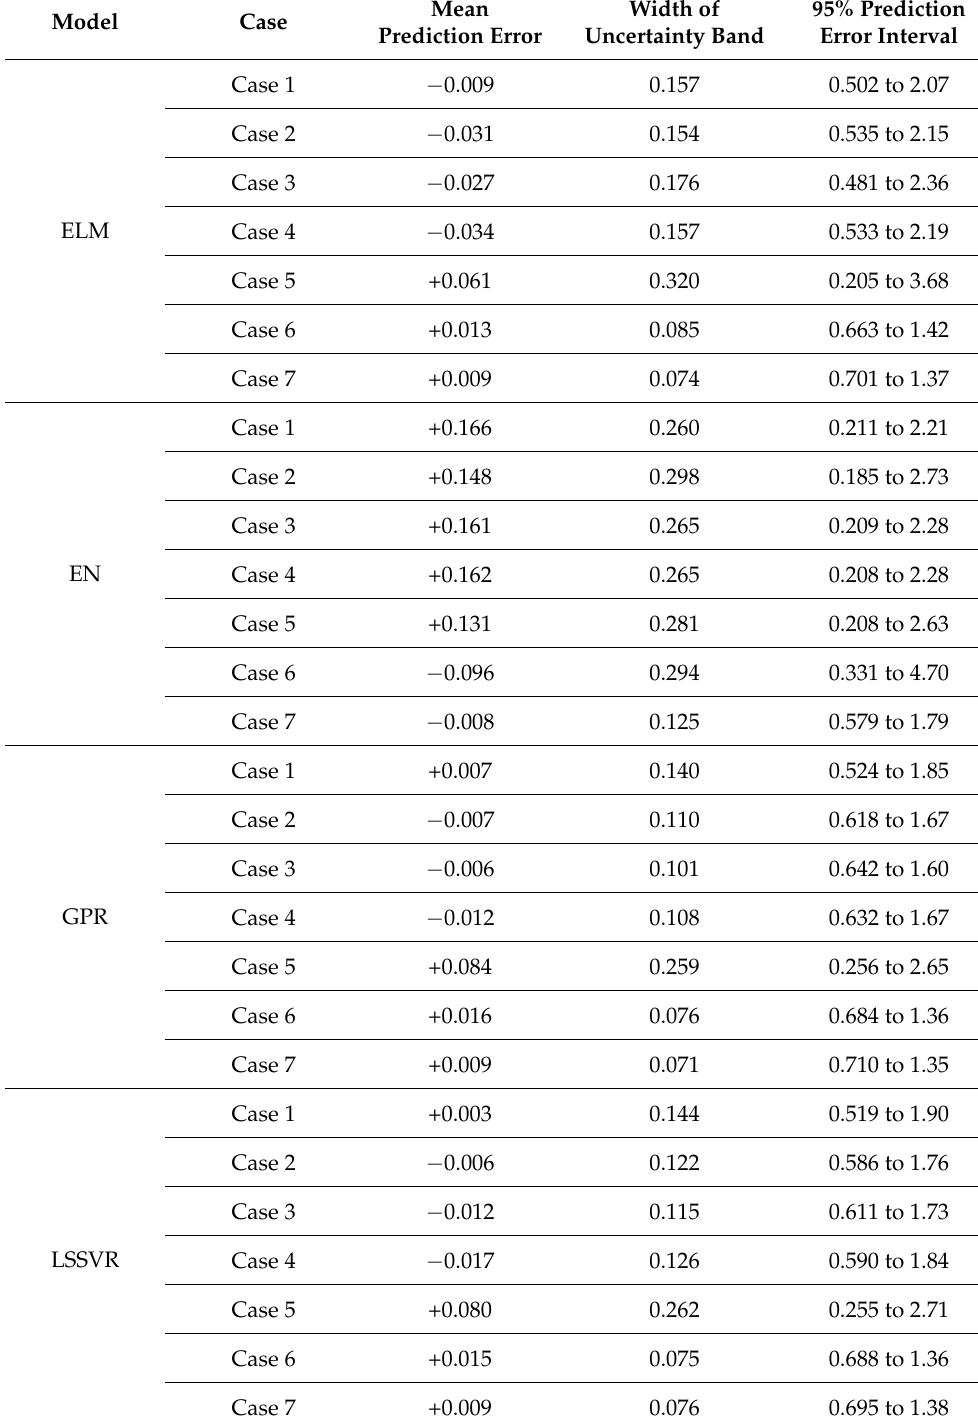
Table 14. Uncertainty estimates for machine learning